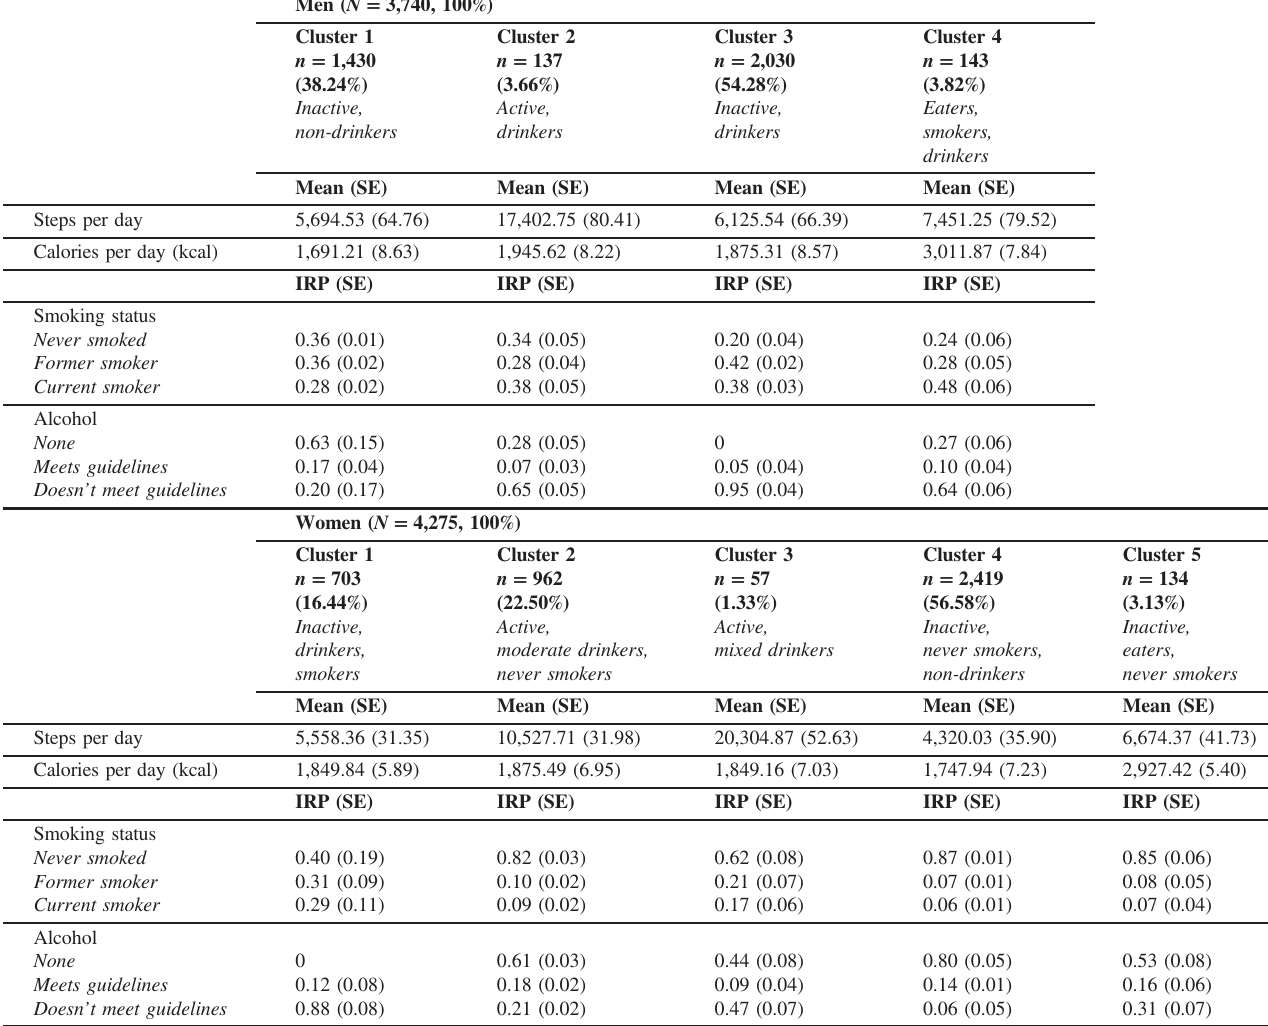
Table 2. Estimates for two-level Latent Pro fi le Analysis models, run separately for men and women